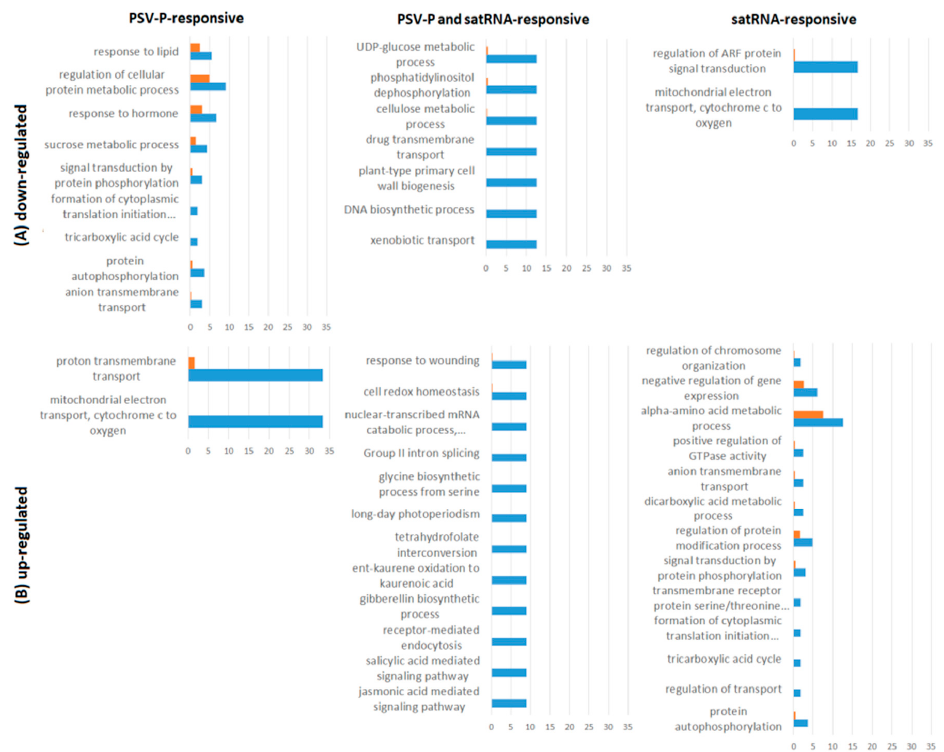
Figure 6. GO enrichment for biological process for phosphoproteins. Data from PSV-P- or PSV-P and satRNA-infected N. benthamiana plant phosphoproteins. The distribution of GO terms was